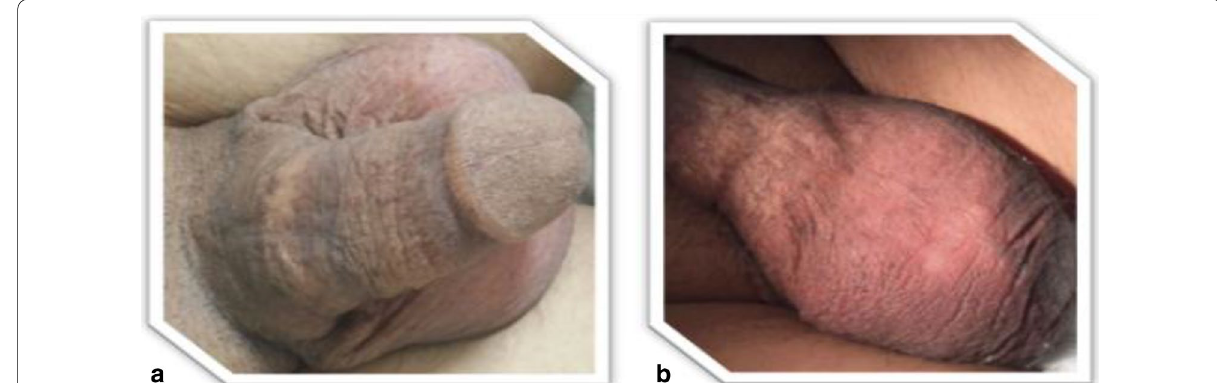
Fig. 1 Sign of infection, redness and edema of penile shaft ( a ) and scrotal wall ( b ), tenderness around the pump and at the site of reservoir